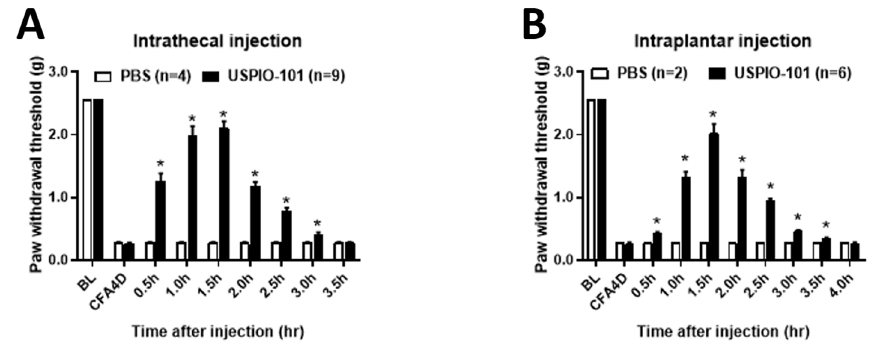
Figure 2. USPIO-101 attenuated chronic inflammatory pain via intrathecal or intraplantar injection. Mechanical pain sensitivity was measured using von Frey microfilaments. USPIO-101 attenuated the analgesia behavior in both ( A ) intrathecal and ( B ) intraplantar injection (10 mg/mL, 10 µL) after CFA paw injection for four days. The paw withdrawal thresholds were measured every 30 min until there was no difference between the three groups. Data were analyzed by two-way ANOVA and post-hoc with Tukey’s test. *: p < 0.05 vs. PBS sham group.